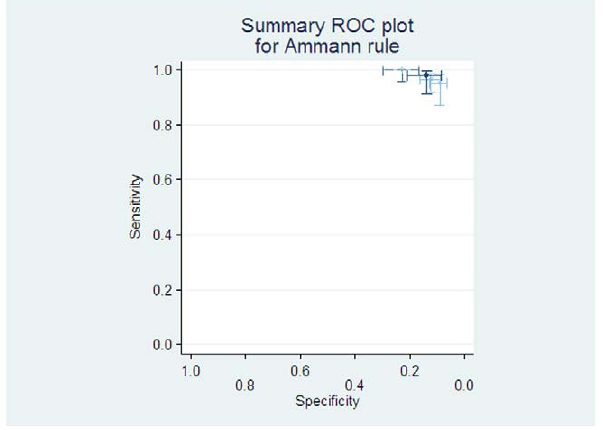
Figure 3. Individual and pooled diagnostic test accuracy of ‘Ammann’ rule. The ROC space plots here has the light lines and circles represent individual studies, with the darker dashed lines showing the study from which the rule was derived, and the heavy dark lines the pooled estimate of sensitivity and specificity, with the univariate 95% confidence intervals.